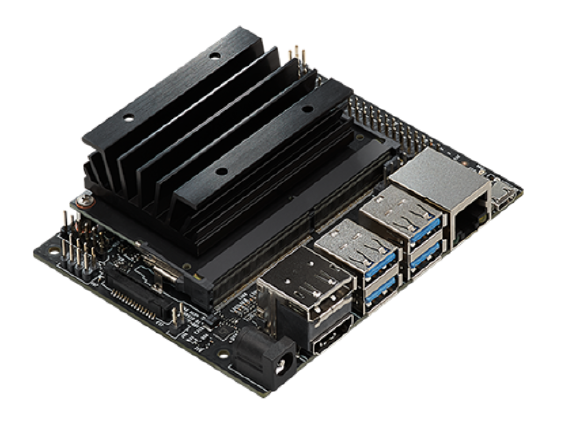
Figure 4. Jetson Nano NVIDIA